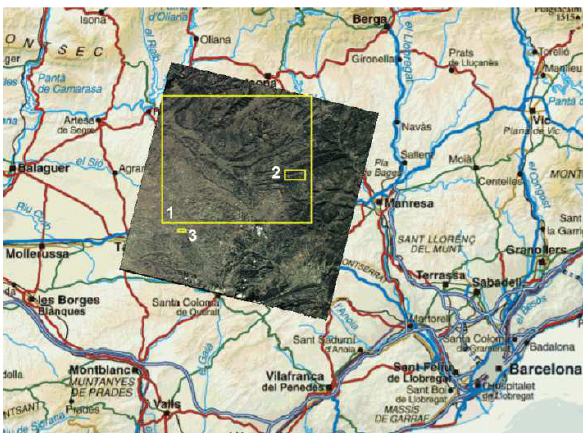
Figure 1: Area covered by ZY-3 imagery with 3 test areas used for DSM quality check